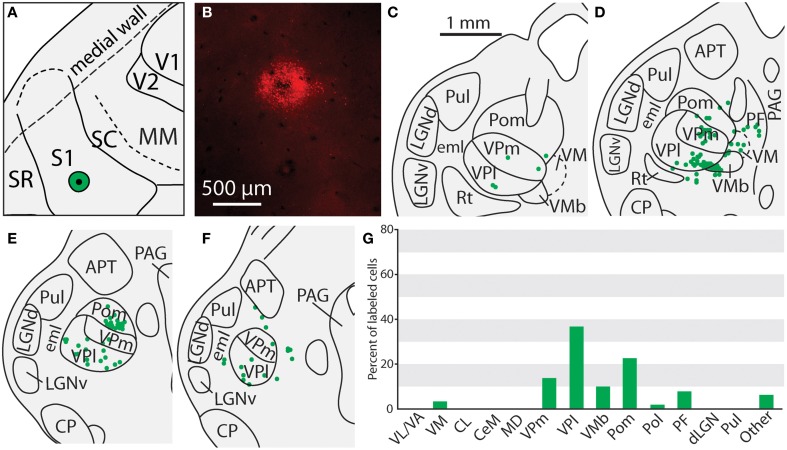
Thalamic projections to the border of the face-body representation in S1 in case 12-18. (A) Location of the FR injection site. (B) Fluorescent image of the FR injection site and surrounding halo. (C–F) Labeled neurons can be seen throughout the medial and lateral divisions of VP, along with labeled cells in Pom and VMb. (G) Percent of labeled thalamic neurons projecting to S1. Conventions as in previous figures.